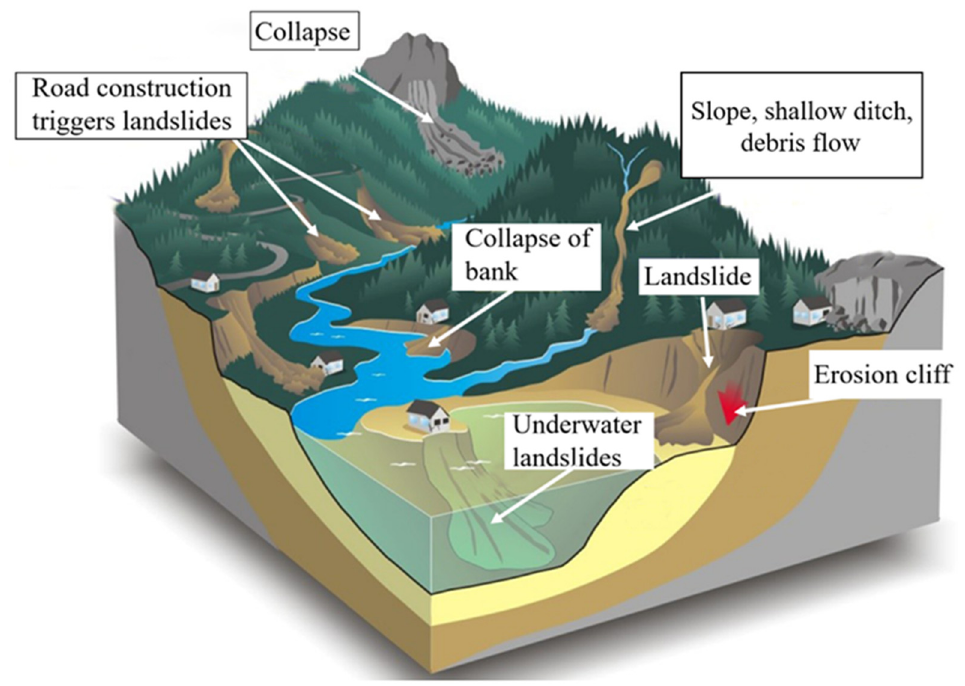
Figure 5. Different types of debris flow under different terrain conditions.